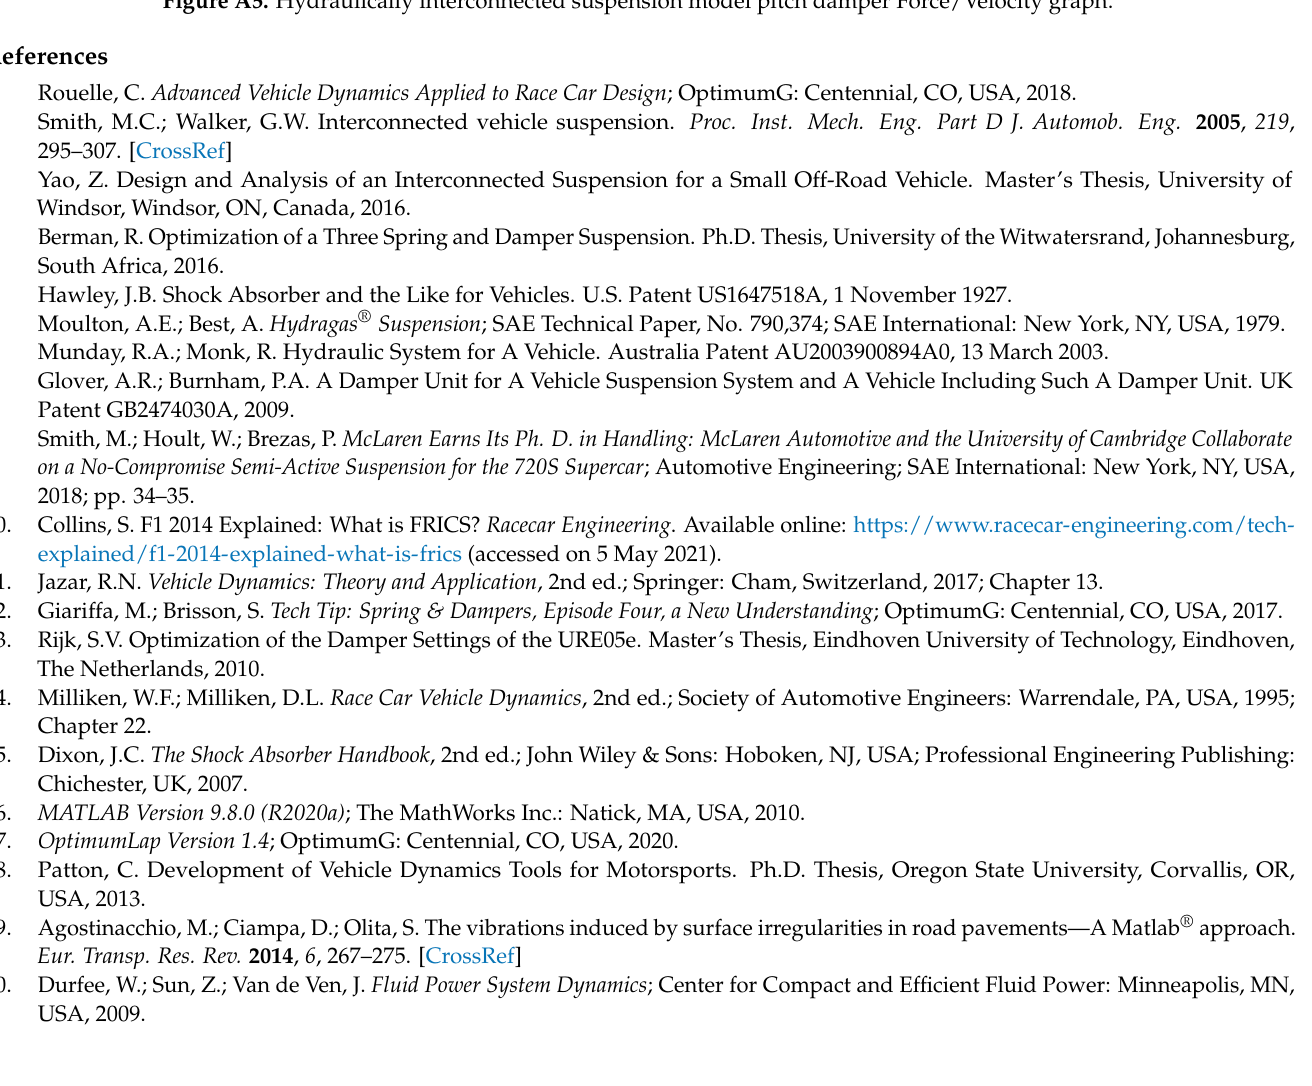
Figure A5. Hydraulically interconnected suspension model pitch damper Force/Velocity